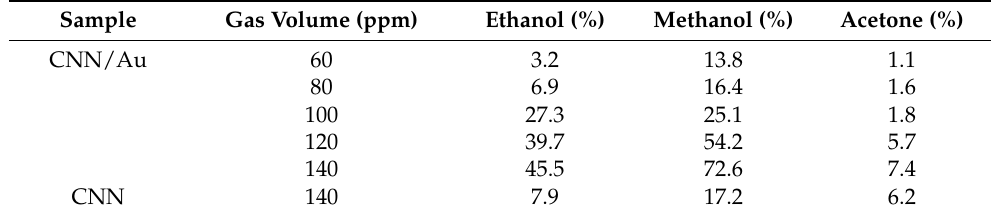
Table 1. The maximum response of the CNN- and CNN/Au-based sensor for different ppm of acetone, methanol, and ethanol vapors.